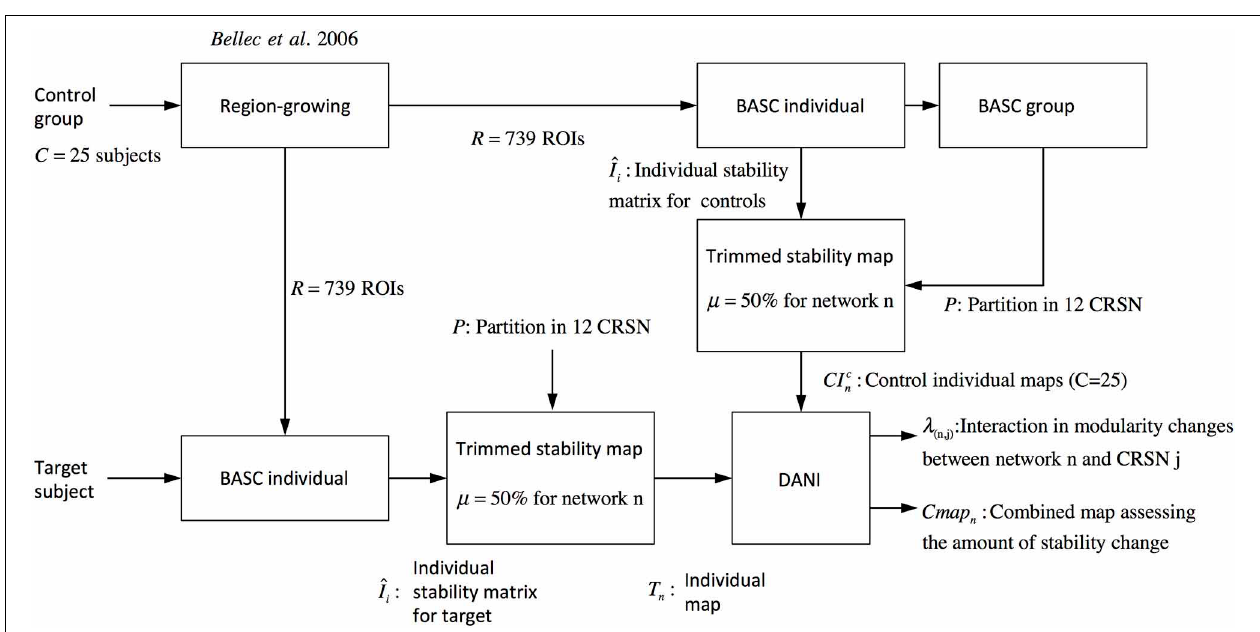
FIGURE 2 | Pipeline summarizing the steps involved in DANI method starting from the preprocessed fMRI images of the control population and the preprocessed images of the target subject on which DANI was applied.